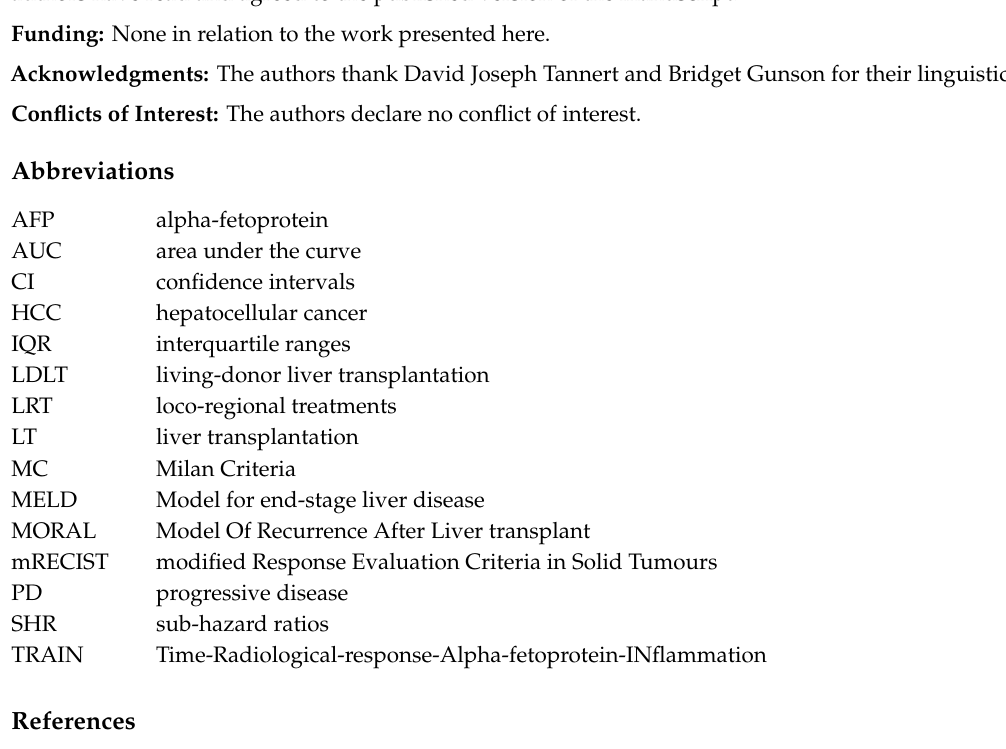
Table S1: Patients out of Milan Criteria and Up-to-Seven Criteria at first referral and liver transplantation in the di ff erent